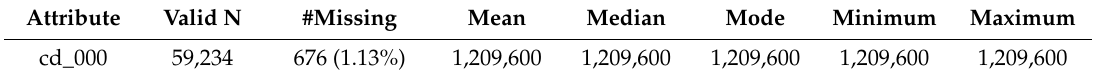
Table 1. Invariant attribute assessment of the selected attribute cd_000.